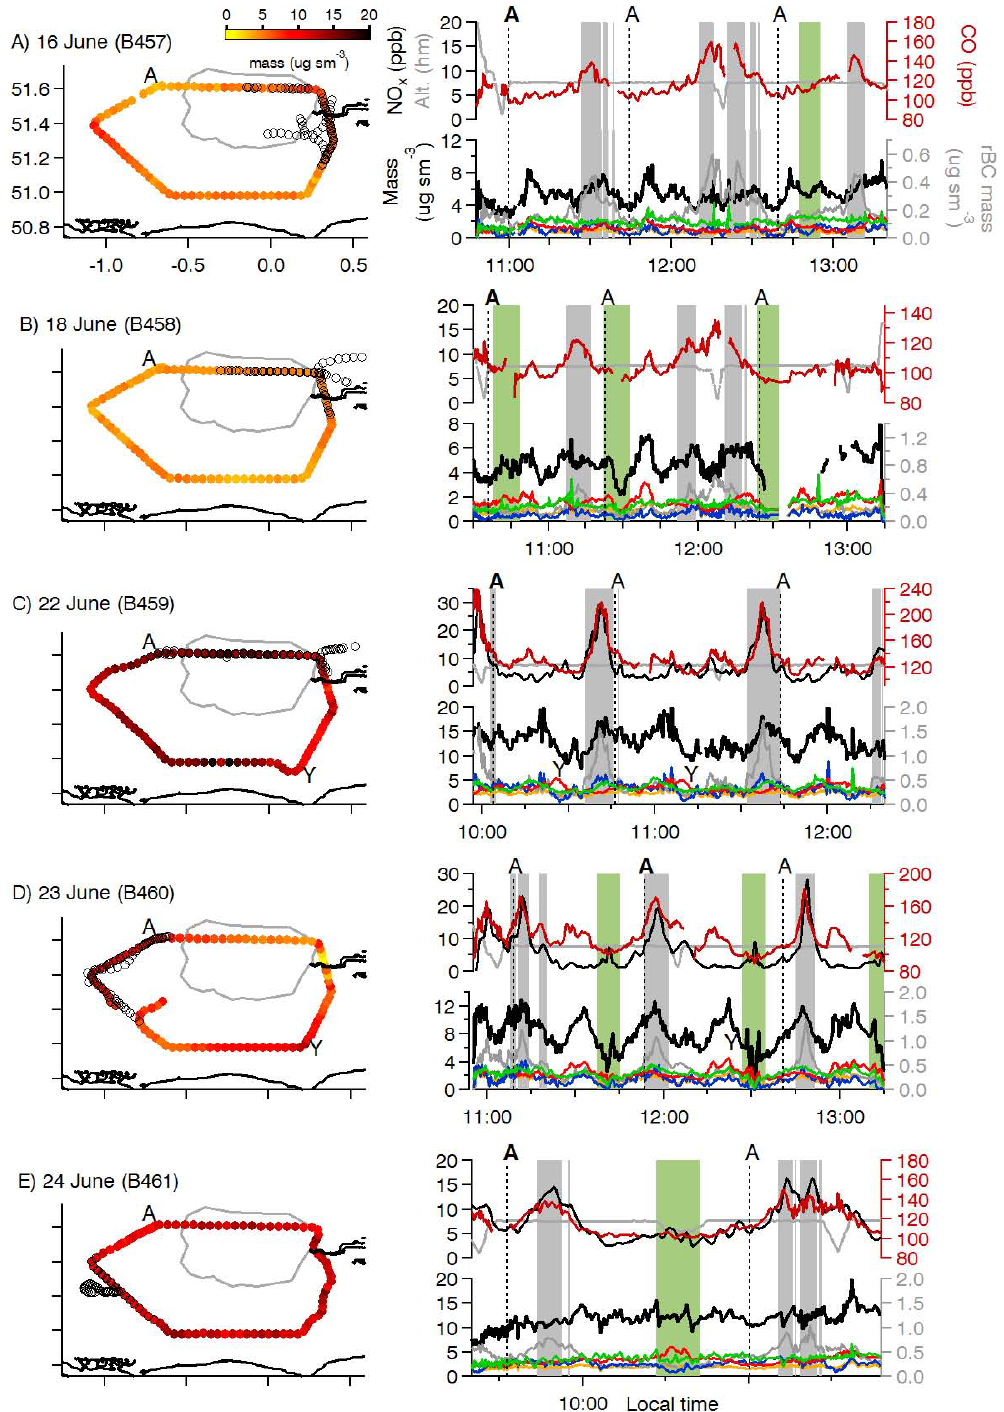
Fig. 11. Examples of aerosol sub-micron mass concentrations measured during a single circuit around London for each flight. Also shown are time series for altitude (grey), nitrogen oxides (black), carbon monoxide (red), aerosol sulphate (red), nitrate (blue), organics (green), ammonium (orange), and refractory black carbon (grey) measured by the AMS and SP2. The time series are restricted to periods when the aircraft was flying circuits around London. Shaded regions and outlined circles indicate regions identified as either in plume or upwind based on air mass classification method described in the